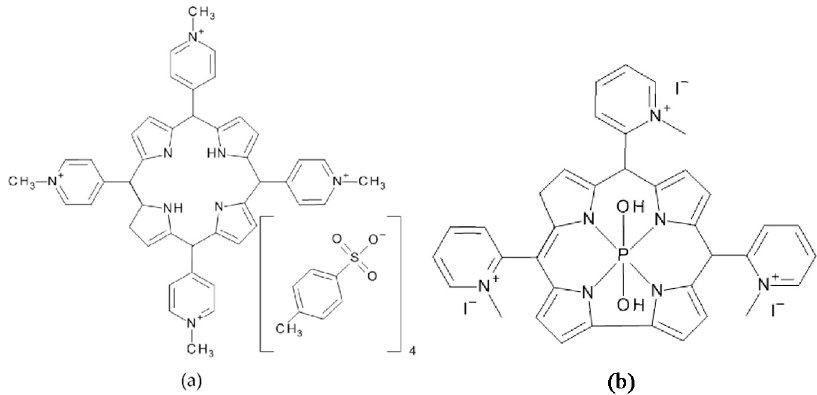
Figure 9 . Chemical structures of the photosensitizers TMPyP and PCor + . Figure 9. Chemical structures of the photosensitizers TMPyP and PCor +